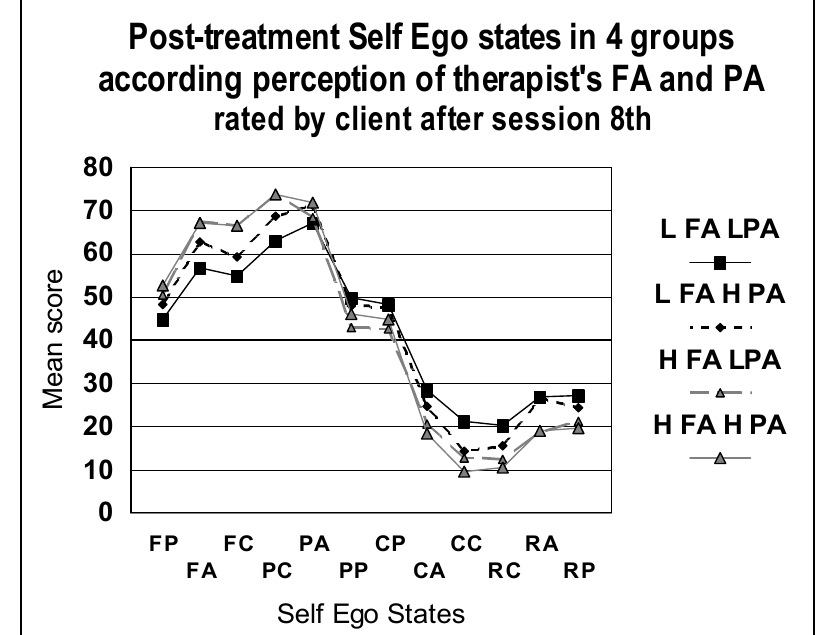
Figure 4: Mean profiles of post-treatment Self ES in four groups of